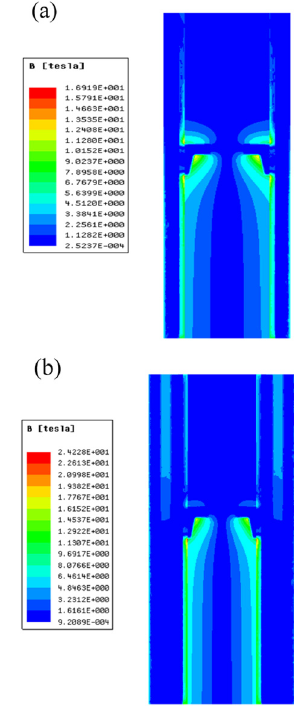
Figure 13: Magnetic fi eld distribution of the rail. ( a ) CFREL and ( b )